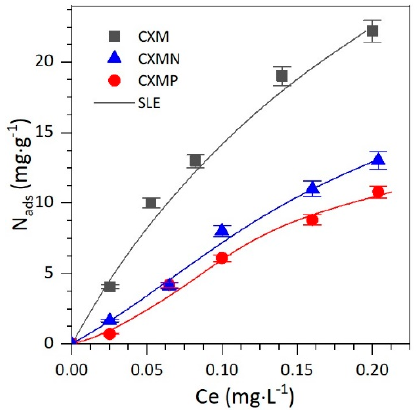
Figure 3. Adsorption isotherms at 25 °C of cannabidiol (CBD) in an aqueous solution of pH = 7 onto carbon xerogel microspheres (CXMs) and CXMs functionalized with melamine (CXMN) and phosphoric acid (CXMP), with experimental data fitted to the solid–liquid equilibrium (SLE) model. Table 3. Parameters obtained for the solid–liquid equilibrium (SLE) model from adsorption isotherms of cannabidiol (CBD) in an aqueous solution of pH = 7 onto carbon xerogel microspheres (CXMs) and CXMs functionalized with melamine (CXMN) and phosphoric acid (CXMP) at 25 °C. The H parameter